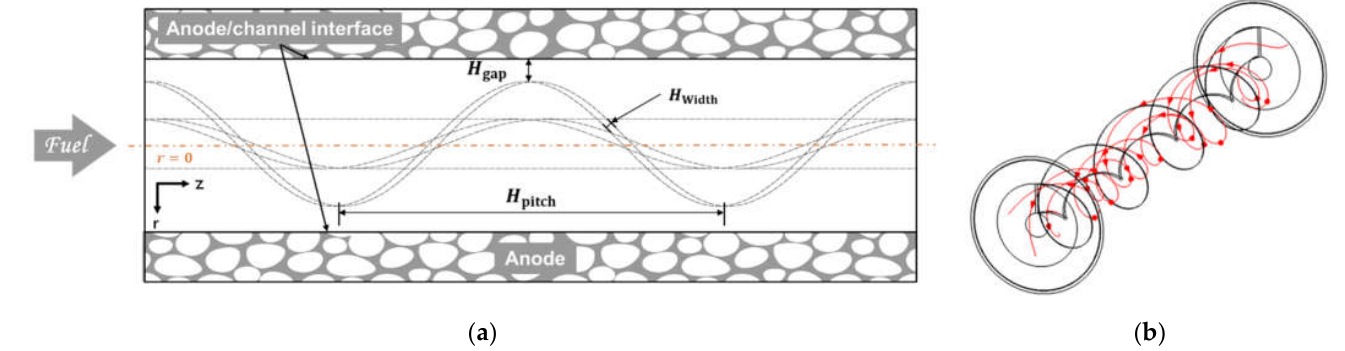
Figure 12. ( a ) A schematic of the porous anode and helical screw insert inside the fuel channel and ( b ) the predicted streamlines in fuel channel of a micro-tubular SOFC with a helical screw insert.